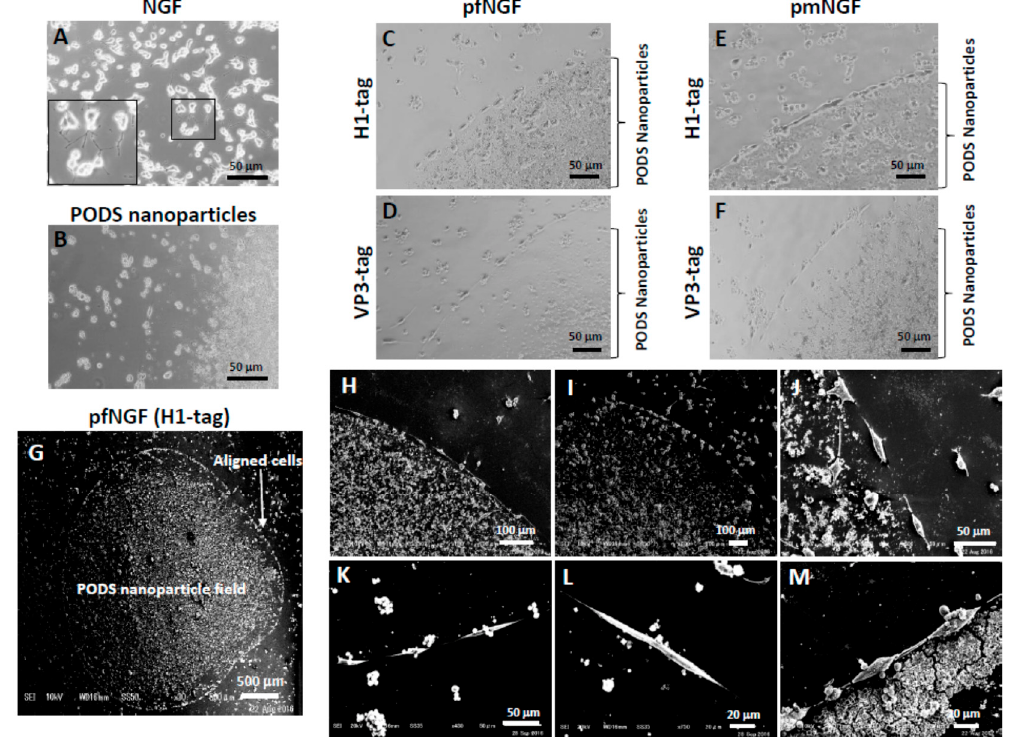
Figure 3. Alignment of PC12 cells surrounding the periphery of a PODS nanoparticle field. PC12 cells were seeded and incubated with NGF-2.5S from the murine submaxillary gland (NGF) ( A ). The box is a magnified image to show randomly extended axons. After empty PODS nanoparticles ( B ) and PODS NGF of H1-tagged pfNGF ( C , G , H , J ), H1-tagged pmNGF ( E , I ), VP3-tagged pfNGF ( D , K , L , M ), and VP3-tagged pmNGF ( F ) were spotted onto collagen-coated cover slips. PC12 cells were seeded and incubated for 5 days without medium exchange.